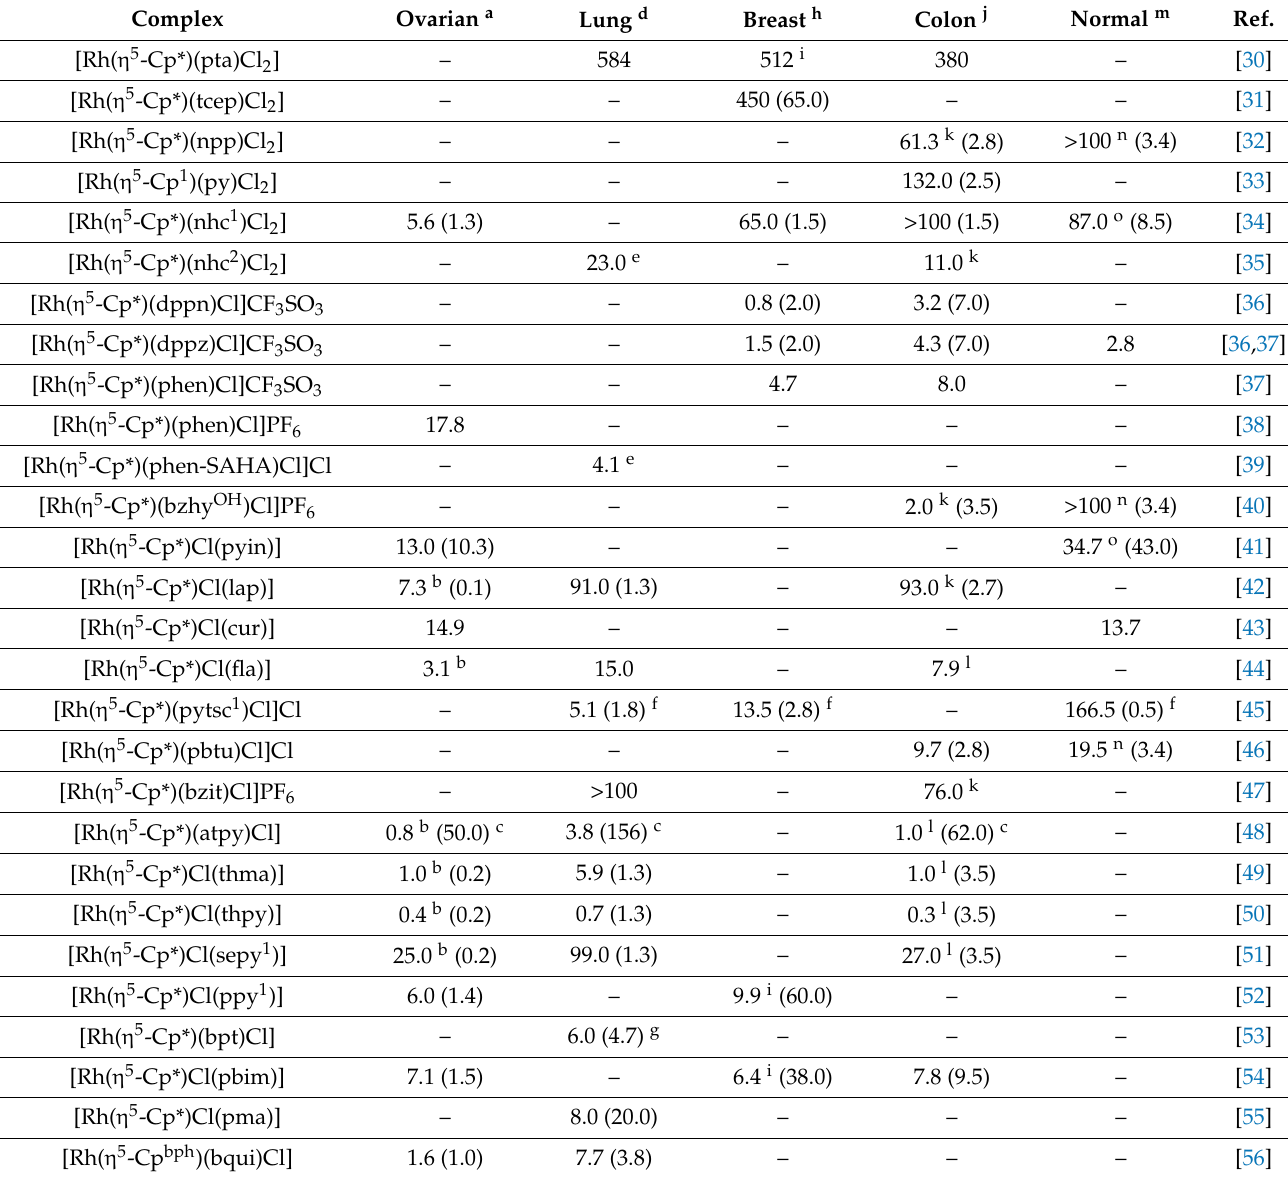
Table 1. In vitro cytotoxicity of [Rh( η 5 -Cp x )(L)Cl 2 ] and [Rh( η 5 -Cp x )(LˆL)Cl] n+ complexes against the selected types of cancer, given together with the results obtained for the non-cancerous (normal) cells. The results are summarised together with the co-studied reference drugs (in parentheses; cisplatin unless stated otherwise), where available. Cp x = cyclopentadienyl ligand, L = a monodentate ligand, LˆL = a bidentate ligand. Complex Ovarian a Lung d Breast h Colon j Normal m